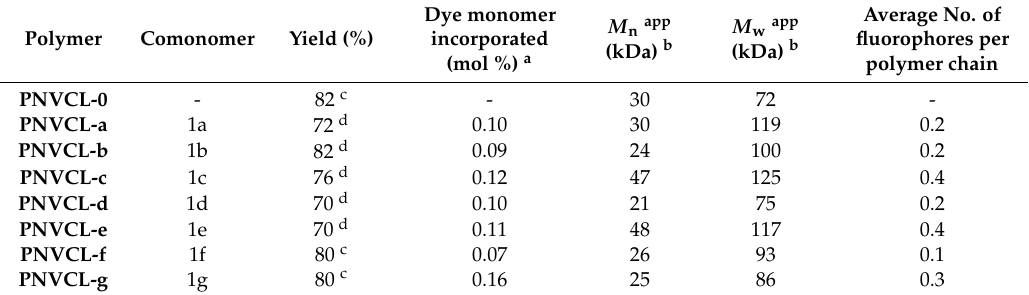
Table 1. Copolymers of N -vinylcaprolactam ( NVCL ) made with 0.1 mol % of functional maleamides and 1 mol % of initiator in the reaction mixture, and their analytical